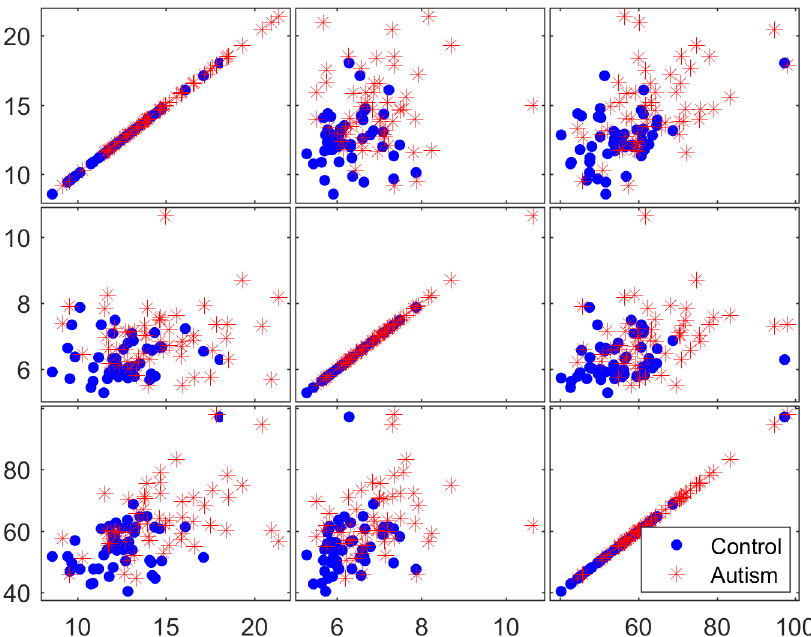
Fig 9. Matrix plots for three representative selectedgenes from the 200 genes filtered by the TT